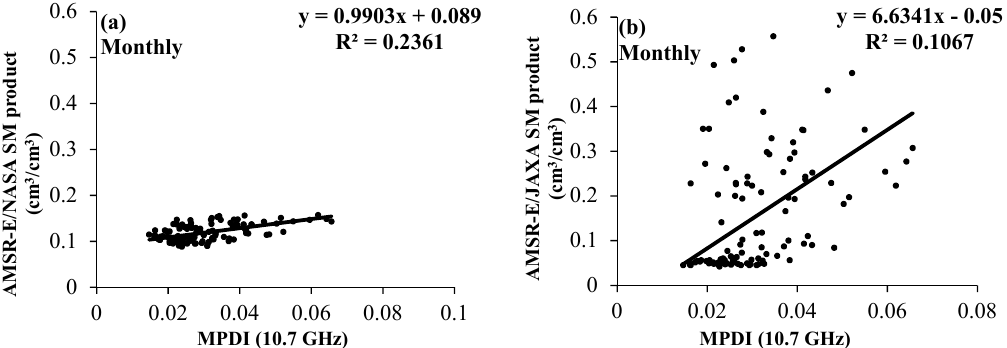
Figure 3. Relationships between the monthly AMSR-E / NASA and JAXA SM values and monthly MPDI in the Naqu area of the Tibetan Plateau in 2011: ( a) NASA SM, all pixels; ( b ) JAXA SM, all pixels.